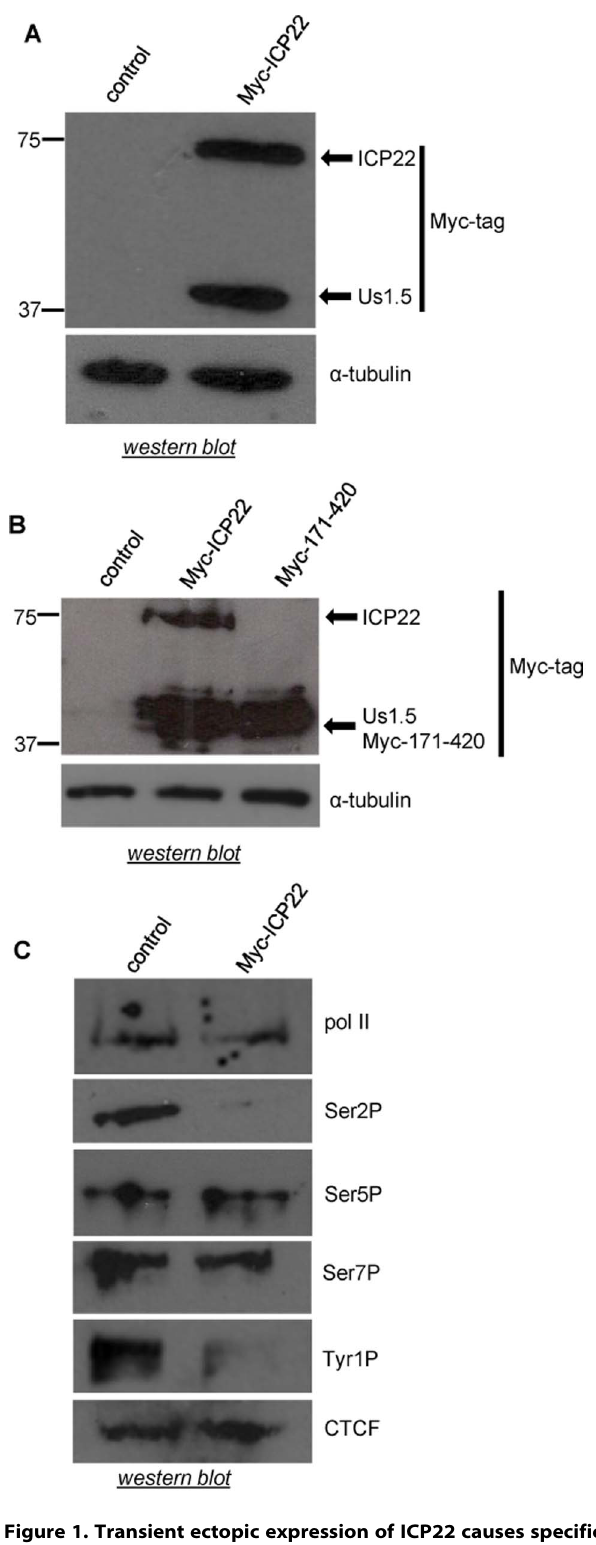
Figure 1. Transient ectopic expression of ICP22 causes specific loss of pol II CTD Ser2 and Tyr1 phosphorylation. ( A ) Myc epitope-tagged ICP22 and U S 1.5 were ectopically expressed in HeLa cells from a transfected expression vector containing the ICP22 open- reading frame followed by three Myc epitope tags. pcDNA3 was used as the control in this and all subsequent transfections. An anti-Myc tag antibody was used for the western blot analysis and the positions